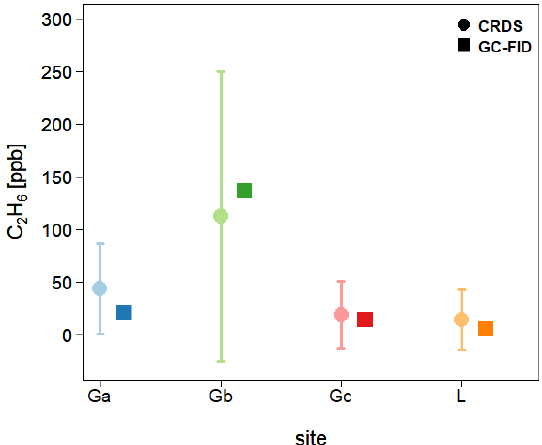
Figure 8. Fieldwork. Comparison of the C 2 H 6 mixing ratio mea- sured in situ by CRDS G2201-i and in the laboratory by GC-FID from flask measurements. CRDS G2201-i measurements during the time of flask sampling. Uncertainties (1 SD) are indicated for both CRDS and